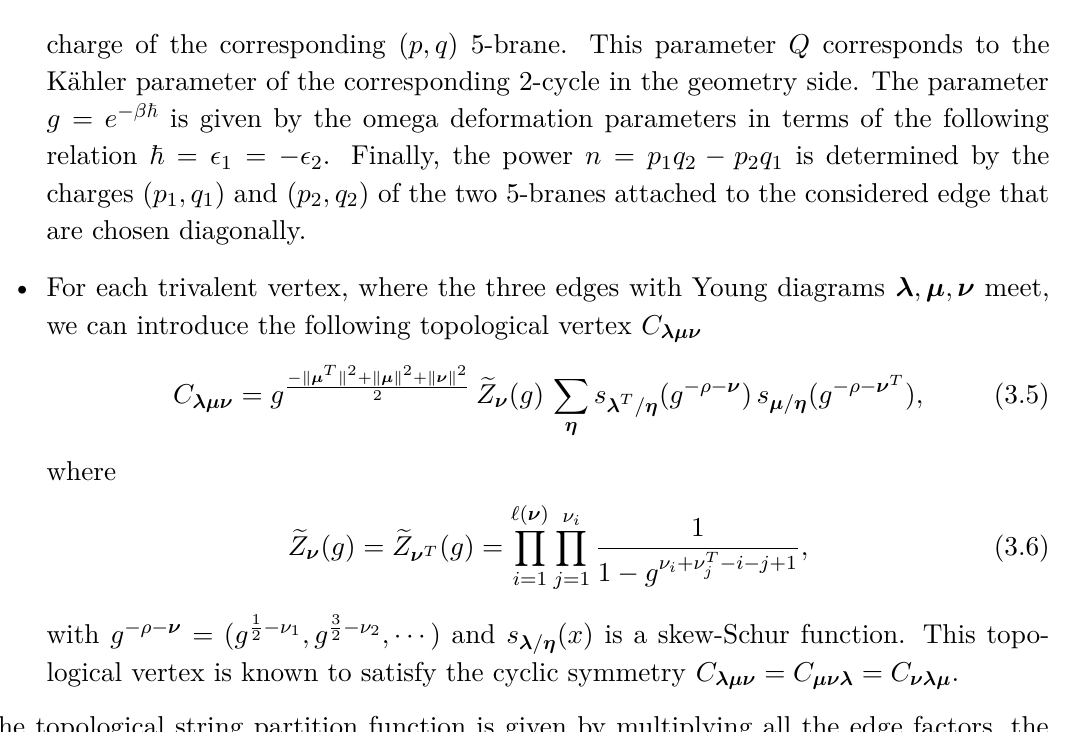
Figure 6 . The two different 5-branes intersecting with each other on the O 5 -plane. The O 5 -plane factor is introduced corresponding to such